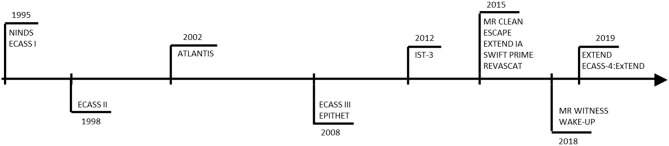
Clinical trials representing 25 years of evolution of therapeutic window of Alteplase.